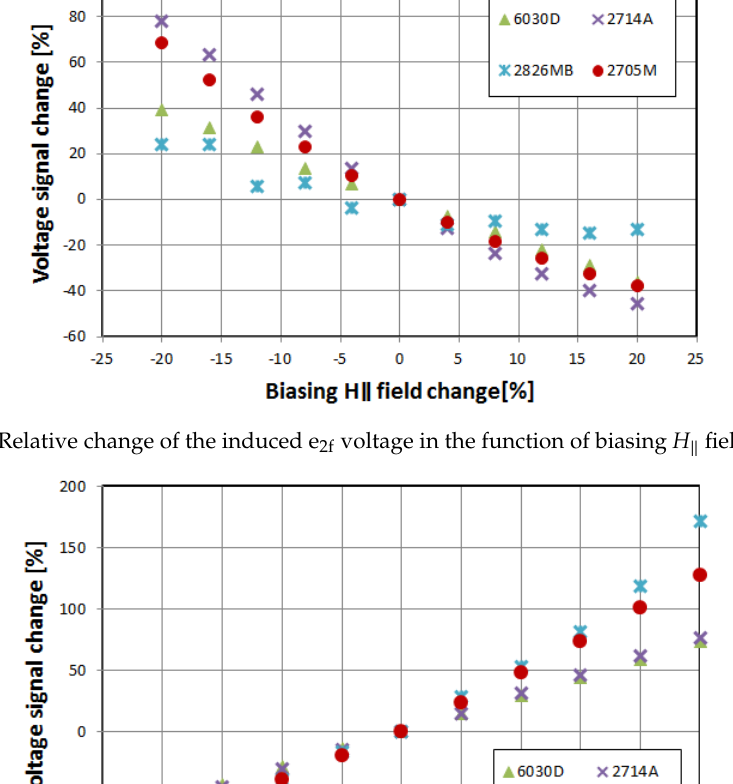
Figure 5. Dependence of induced e 2f voltage on tensile stress, alloy 2826MB. Due to the low-level signal, and thus high uncertainty, measurement hysteresis was not recorded.